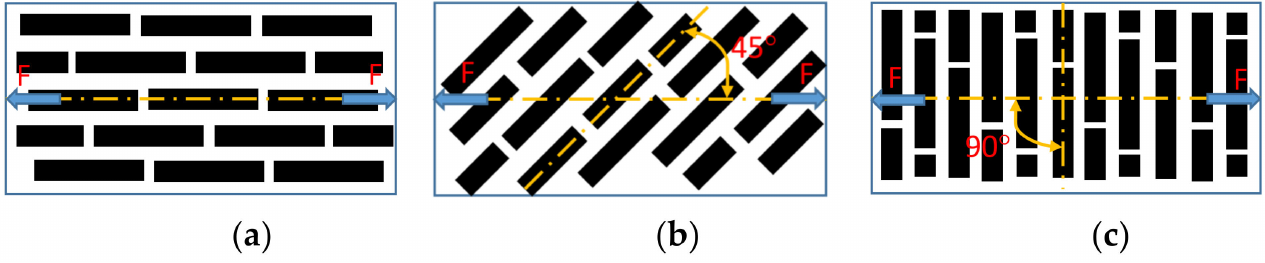
Figure 1. Fiber orientation with the respect to load direction: ( a ) 0 ◦ ; ( b ) 45 ◦ ; ( c ) 90 ◦